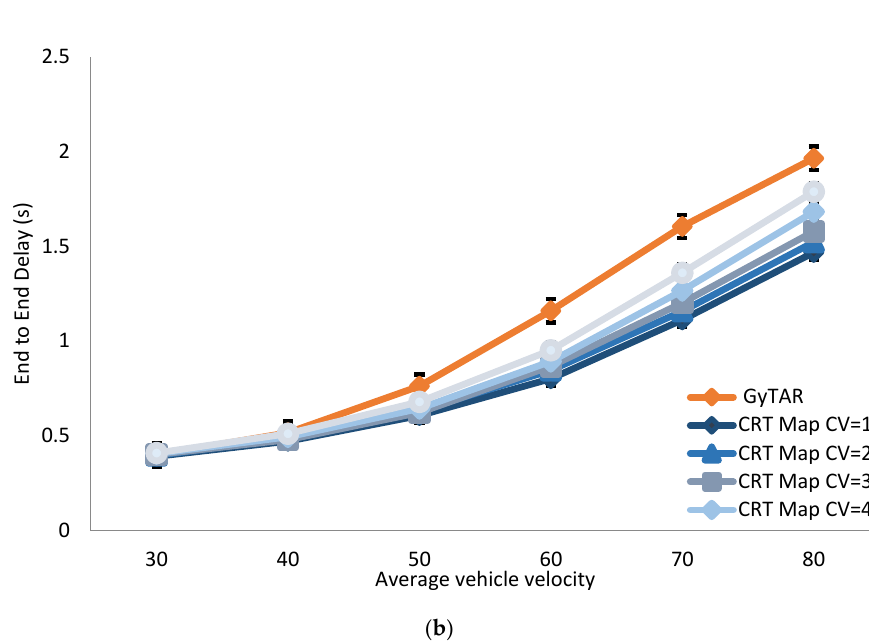
Figure 13. End-to-end delay vs. different value of CV: ( a ) 100 vehicles; and ( b ) 300 vehicles.